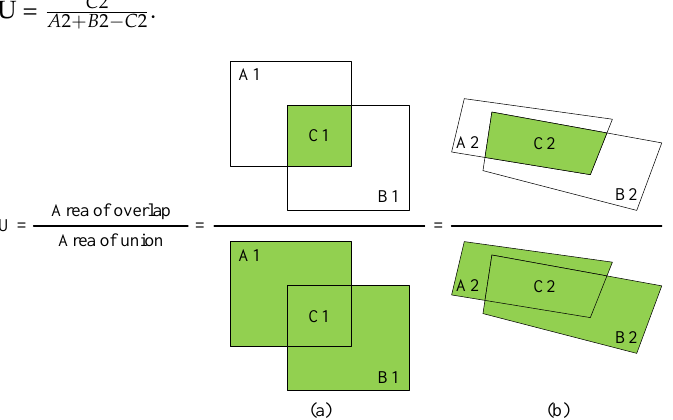
Figure 6. ( a ) IoU between two horizontal boxes. ( b ) IoU between two quadrilateral boxes.